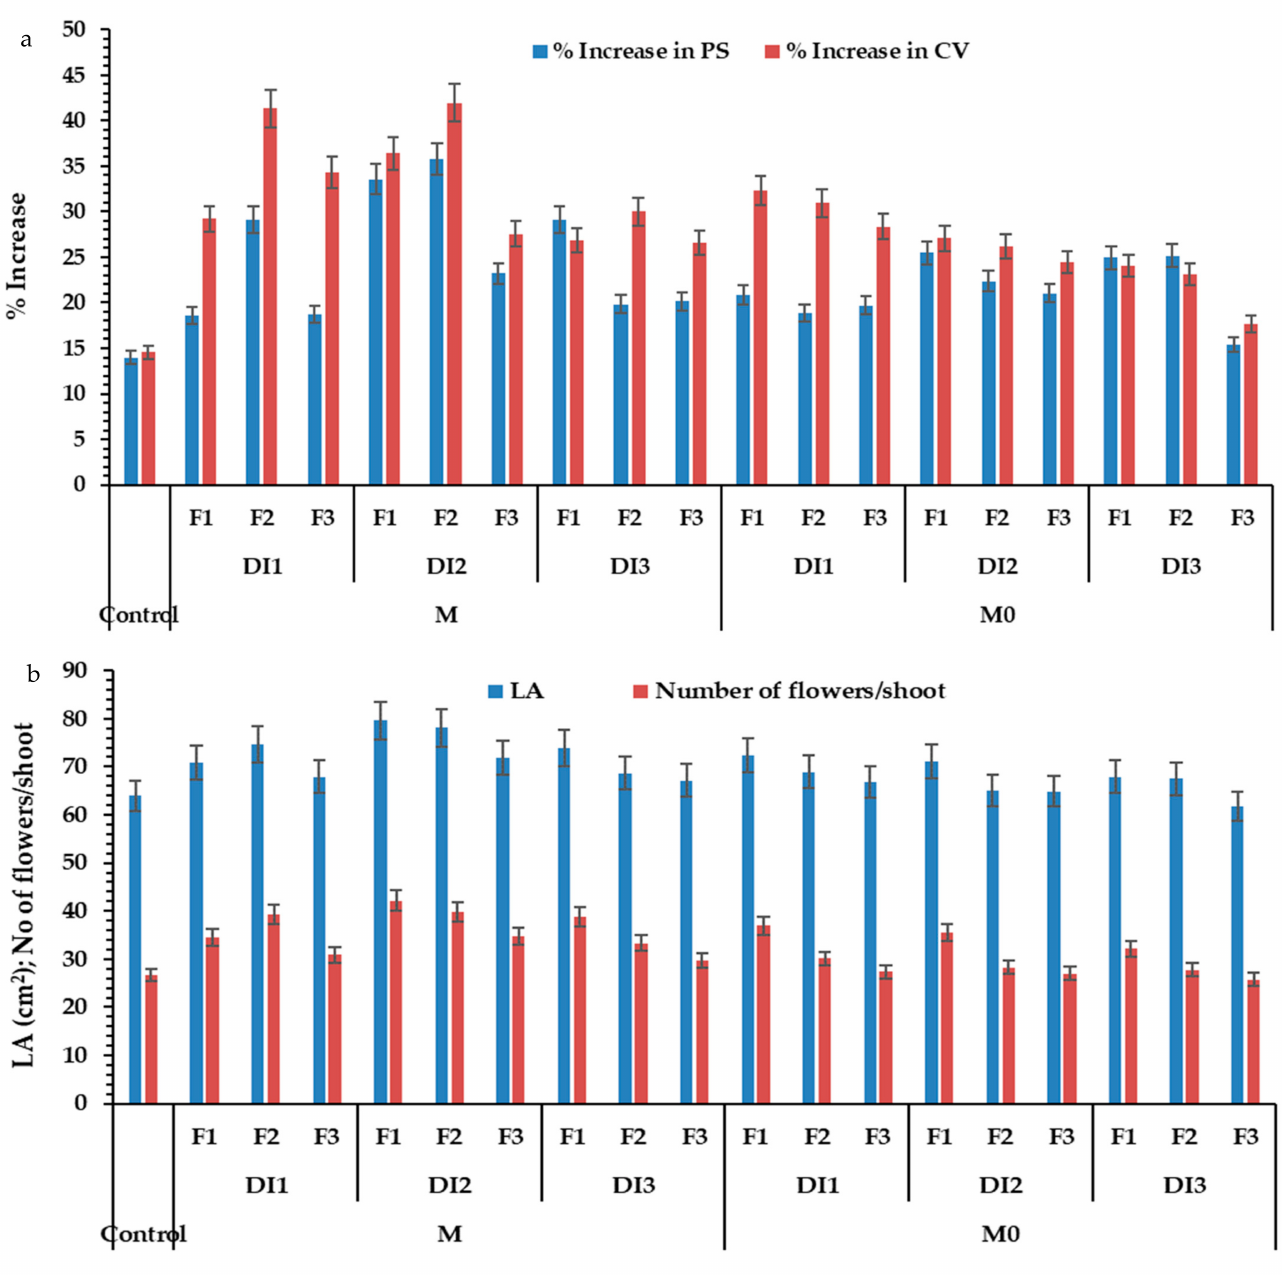
Figure 1. Interactive effect of mulching in combination with drip irrigation and nutrient management on ( a ) increase in plant spread and canopy volume and ( b ) leaf area and number of flower/shoot of guava cv. VNR Bihi. M (mulch), M0 (no mulch); DI (drip irrigation level: 100% CPE, 80% CPE, 60% CPE); F (fertigation level: 100% RDF, 80% RDF, 60%